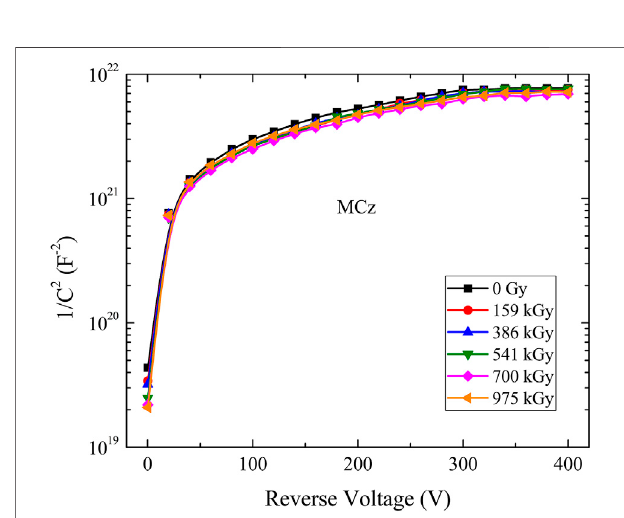
FIGURE 11 | Capacitance measurements, plotted as 1/C 2 versus the reverse voltage applied to a pristine MCz diode (0 Gy) and after irradiation up to 975 kGy in incremental steps of almost 150